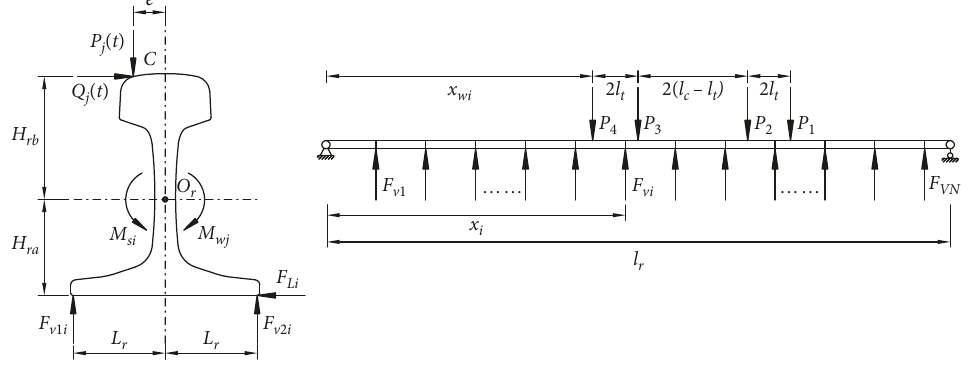
Figure 5: Rail force